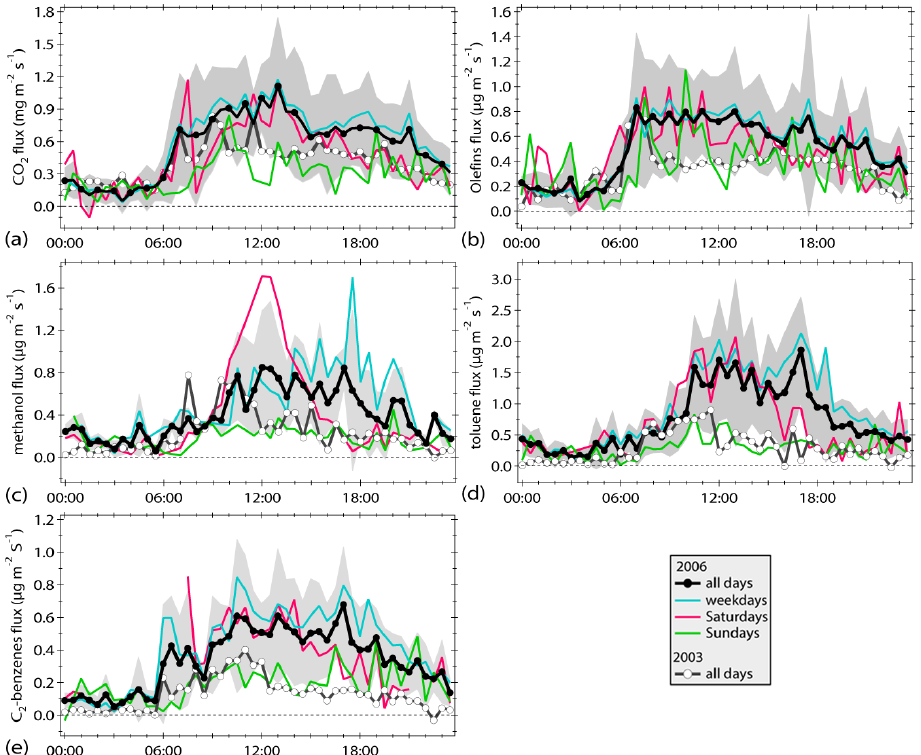
Fig. 3. Average diurnal patterns of the flux of (a) CO 2 , (b) mix of olefinic VOCs as propylene detected by the FOS, (c) methanol, (d) toluene, and (e) C 2 -benzenes for the entire study, weekdays, Saturdays and Sundays. The fluxes measured in 2003 at the CENICA site are included as reference. The grey shadows represent ± 1 standard deviation from the total 2006 averages, and give an indication of the day-to-day variability in each phase of the daily cycle. The time scale corresponds to the local standard time. Table 4. Ratios between the fluxes measured on Saturdays and Sundays and the fluxes measured on weekdays for different periods of the day. CO 2 Olefins C 2 -benzenes Toluene Methanol Sat. Sun. Sat. Sun. Sat. Sun. Sat. Sun. Sat. Sun. All day 0.76 0.49